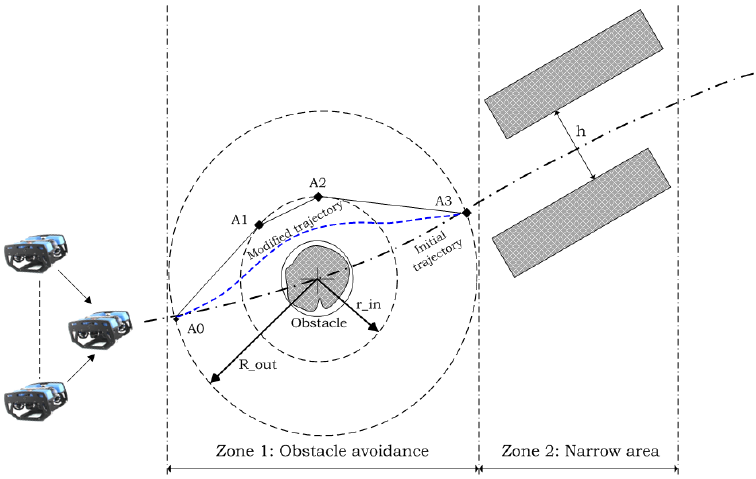
Figure 4. Partition of two regions of a UUV for obstacle